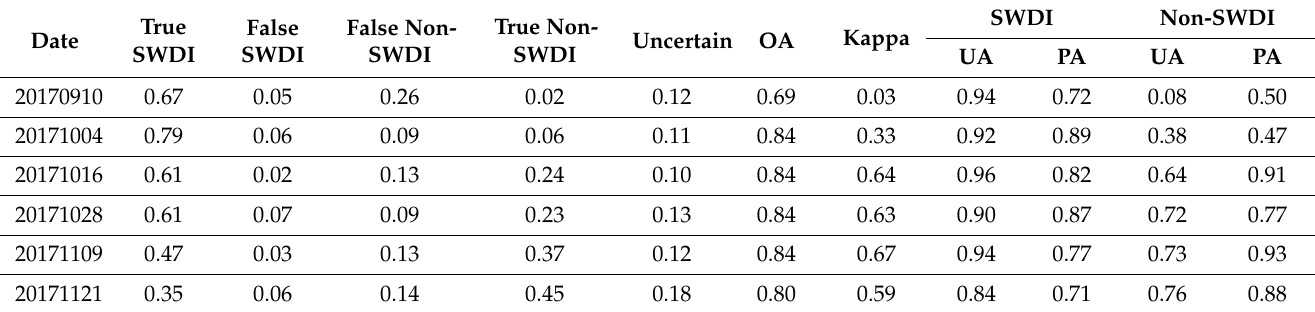
Table 2. SWDI validation metrics based on the selected set of thresholds with n SWDI = 20% and n Non-SWDI = 10%. ‘Uncertain’ class was not taken into account when calculating other accuracy metrics. The percentages of the first four classes (True SWDI, False SWDI, False Non-SWDI, and True Non-SWDI) add up to